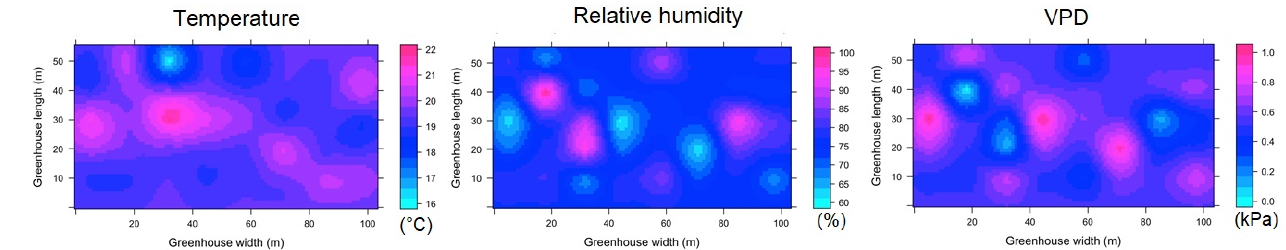
Figure 8. Spatial distribution predicted by kriging, for temperature, relative humidity and VPD in MG and for ESRL 5.